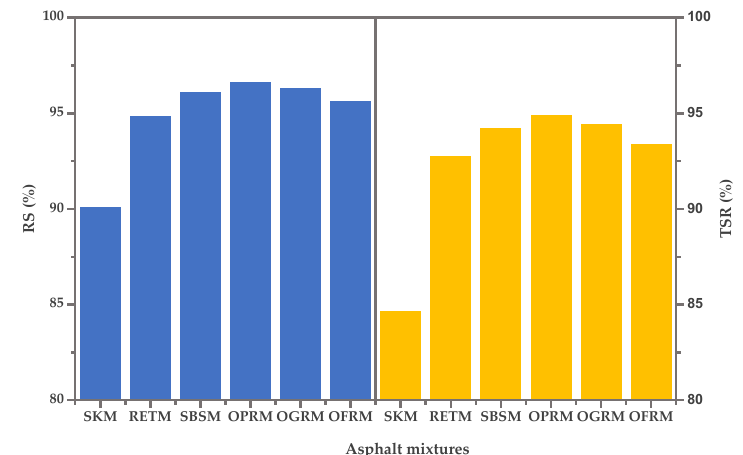
Figure 9. Marshall immersion test and the freeze-thaw splitting test results of asphalt mixtures. Table 11. Prices of materials per